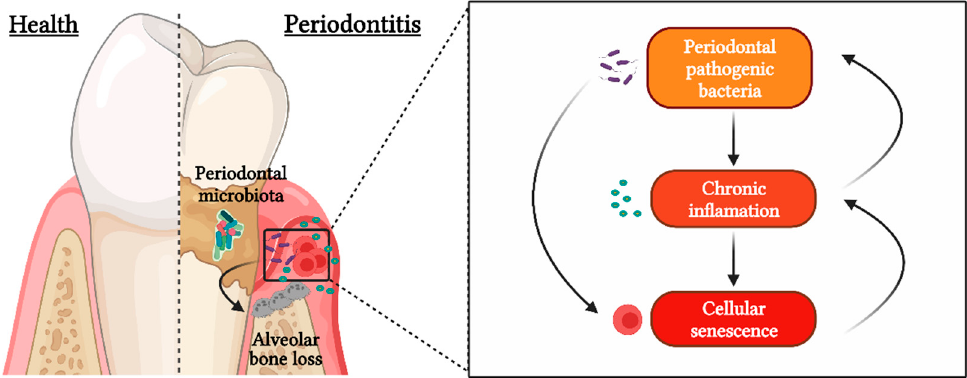
Figure 1. Cellular senescence during periodontitis. Periodontal pathogenic bacteria are capable of causing cellular senescence through the expression of their virulence factors and maintaining a state of chronic inflammation over time, which also induces a favorable nutritional niche for the establishment of these microorganisms and leads to immune dysregulation and consequent tooth-supporting alveolar bone resorption.